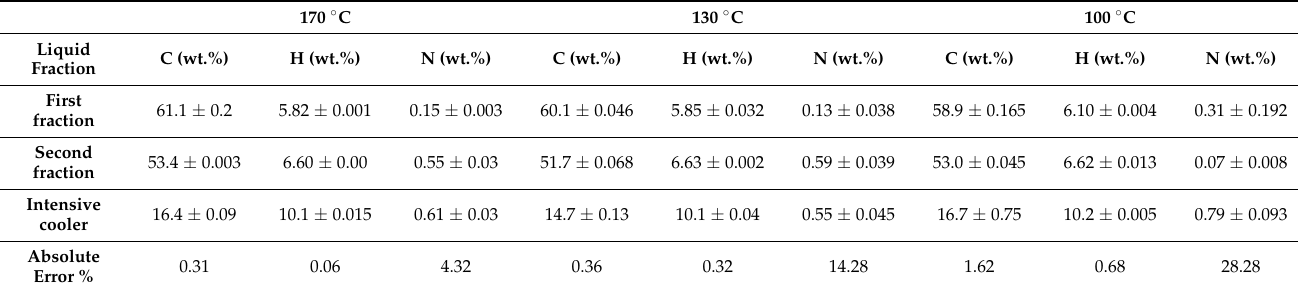
Table 7. CHN analysis of the produced cuts.